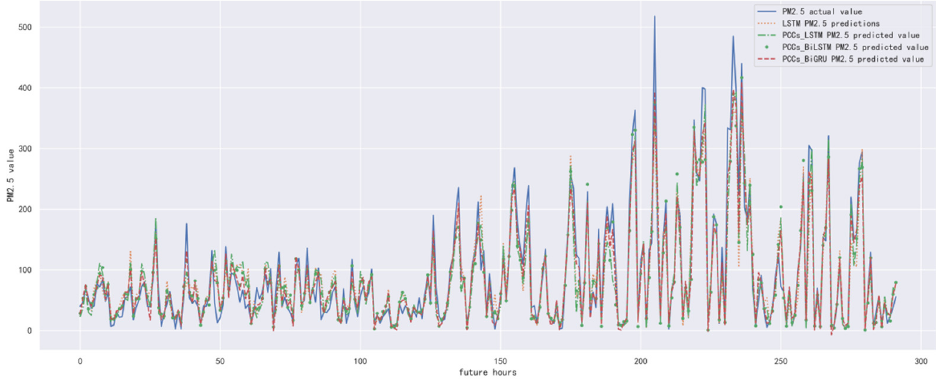
Figure 13. The schematic diagram of predicted PM 2.5 concentration in the next four hours.